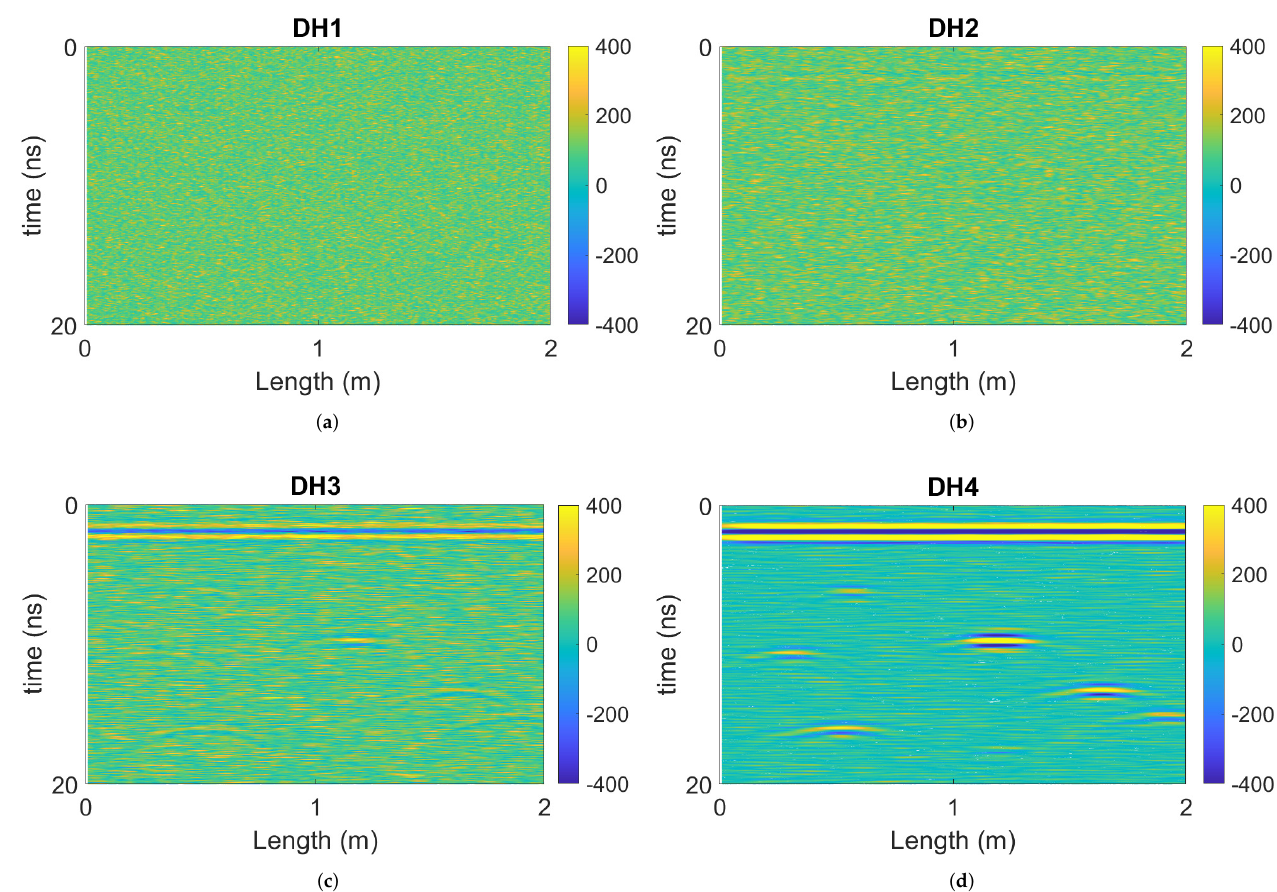
Figure 8. The horizontal detail coefficients of ( a ) 1st-layer DH 1 , ( b ) 2nd-layer DH 2 , ( c ) 3rd-layer DH 3 , and ( d ) 4th-layer DH 4